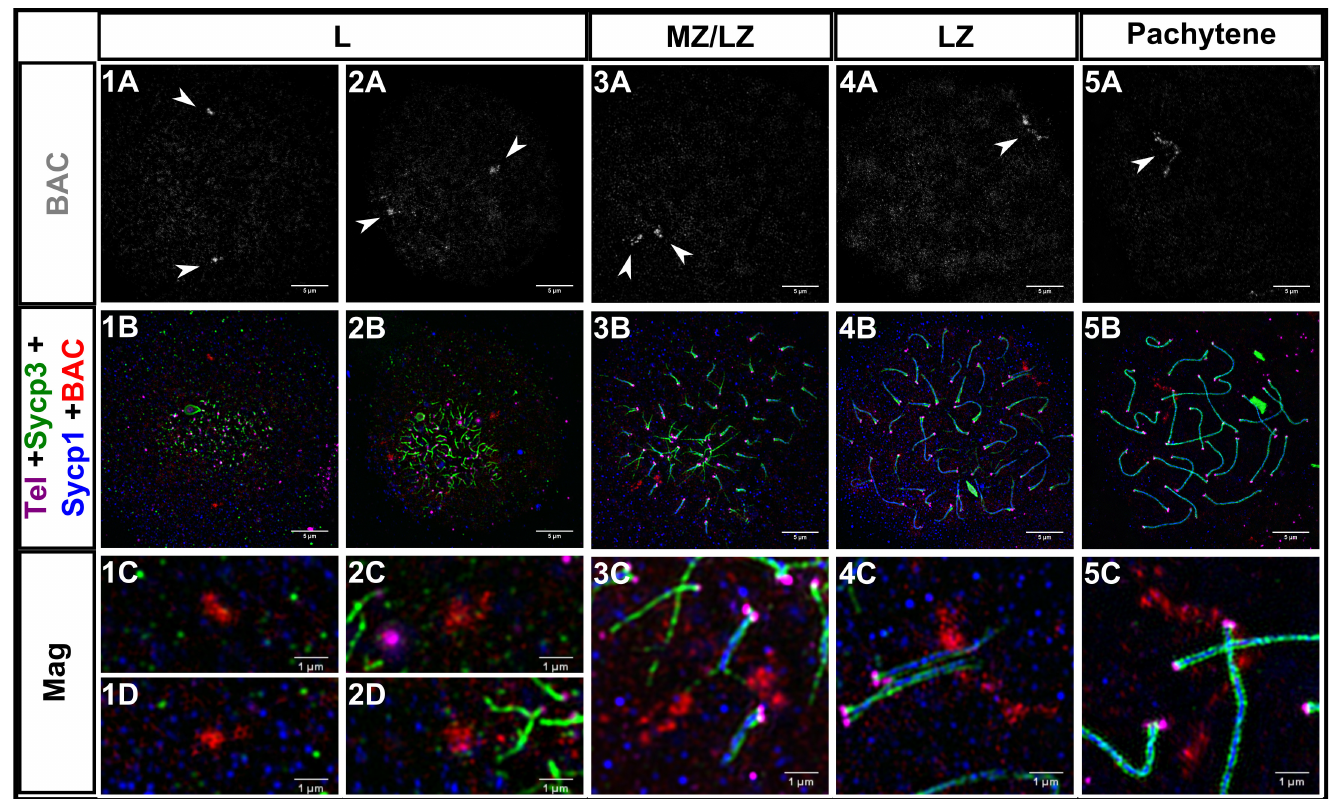
Fig 3. Homologous chromosome pairing at interstitial sites is coincident with synapsis in zebrafish male meiosis I. 1A-5A: Fluorescent in situ hybridization with a BAC probe (gray, white arrowheads) to a region ~10Mb from the telomere on chromosome 5. 1B-5B: Same images as 1A-5A plus telomeres (Tel; magenta), Sycp3 (green), and Sycp1 (blue); the BAC is in red. 1C-5C, 1D-2D: Magnifications (Mag) for each of the corresponding panels above. 1A-5B scale bar = 5 μ m. Mag scale bar = 1 μ m. Leptotene (L), mid to late zygotene (MZ/LZ); late zygotene (LZ). Note that images for panel series 3 and 5 are from a spreading procedure performed on a separate day from panel series 1, 2, and 4, and are included to illustrate a rare observation where BAC probes are located on axes where SC is extending (3C) and also where the BAC signal is highly elongated